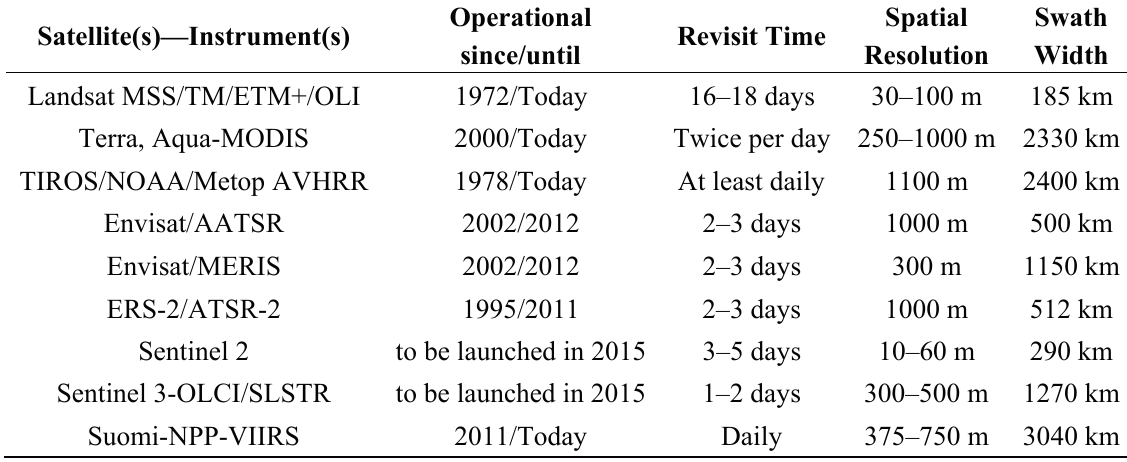
Table 2. Remote Sensing instruments used to map snow cover from the reflective part of the